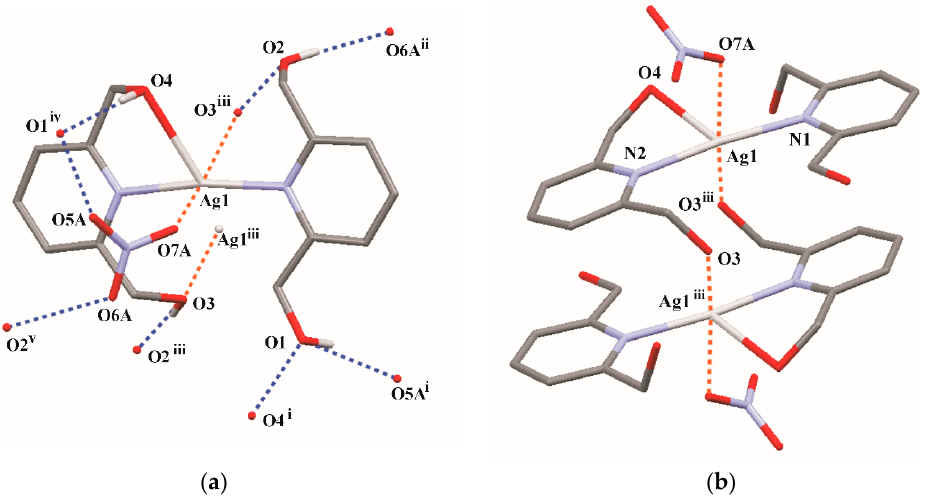
Figure 2. A scheme of the different-type interactions observed in crystal structure of 3 ( a ) and a